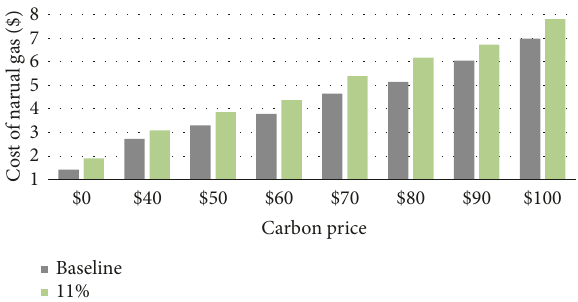
Figure 9: Analyzing the impact of demand variation and carbon price on cost of biogas.